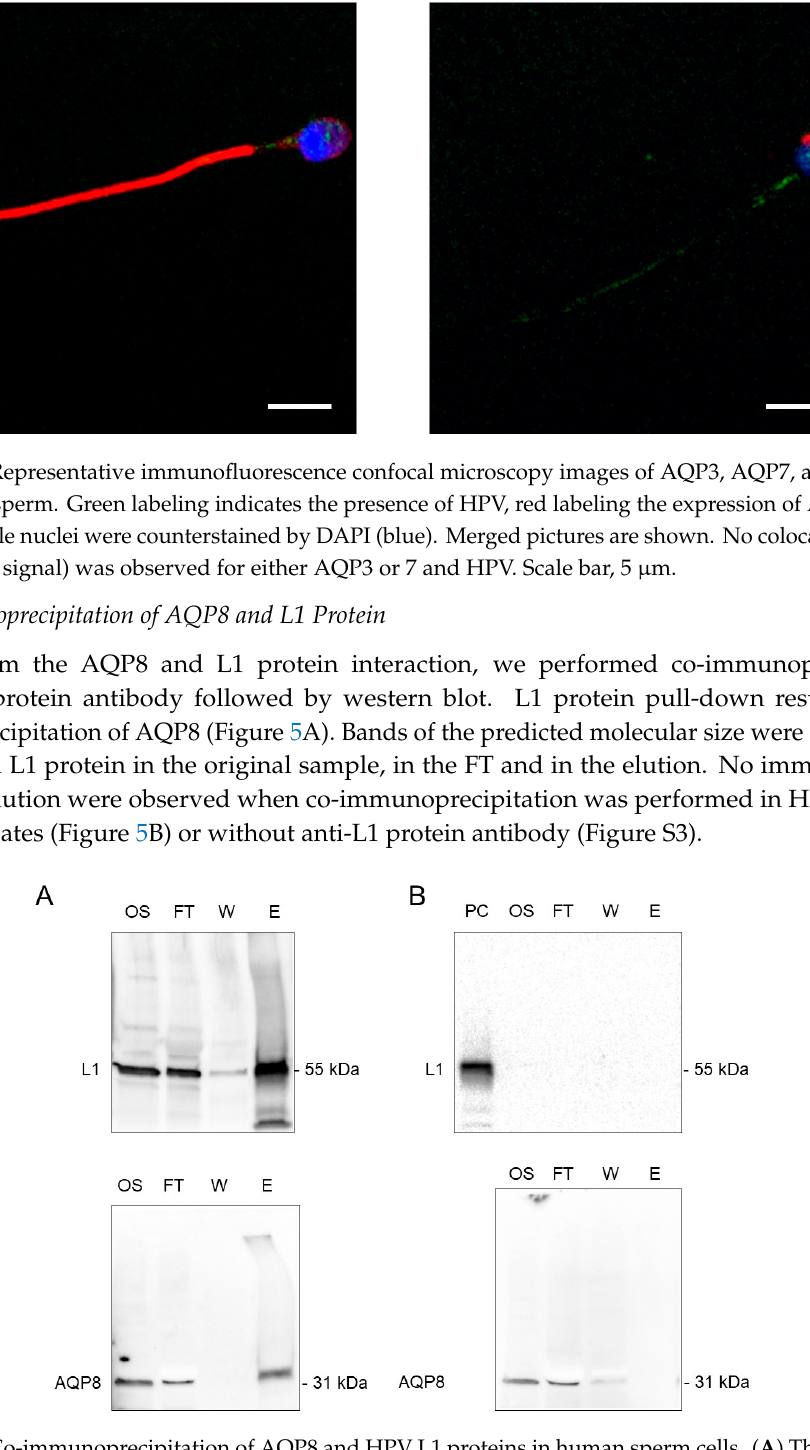
Figure 5. Co-immunoprecipitation of AQP8 and HPV L1 proteins in human sperm cells. ( A ) The sperm cell lysates of HPV16 infected subjects were subjected to co-immunoprecipitation with a HPV L1 specific antibody; protein expression of both AQP8 and L1 was detected by immunoblotting with anti-AQP8 and with anti-HPV antibodies as indicated in Materials and methods. ( B ) As negative control, HPV-negative sperm cells lysates were incubated with the anti-HPV antibody. Major bands of AQP8 and L1 proteins were shown. OS, original sample; FT, flow-through; W, wash; E, elution, PC, positive control.